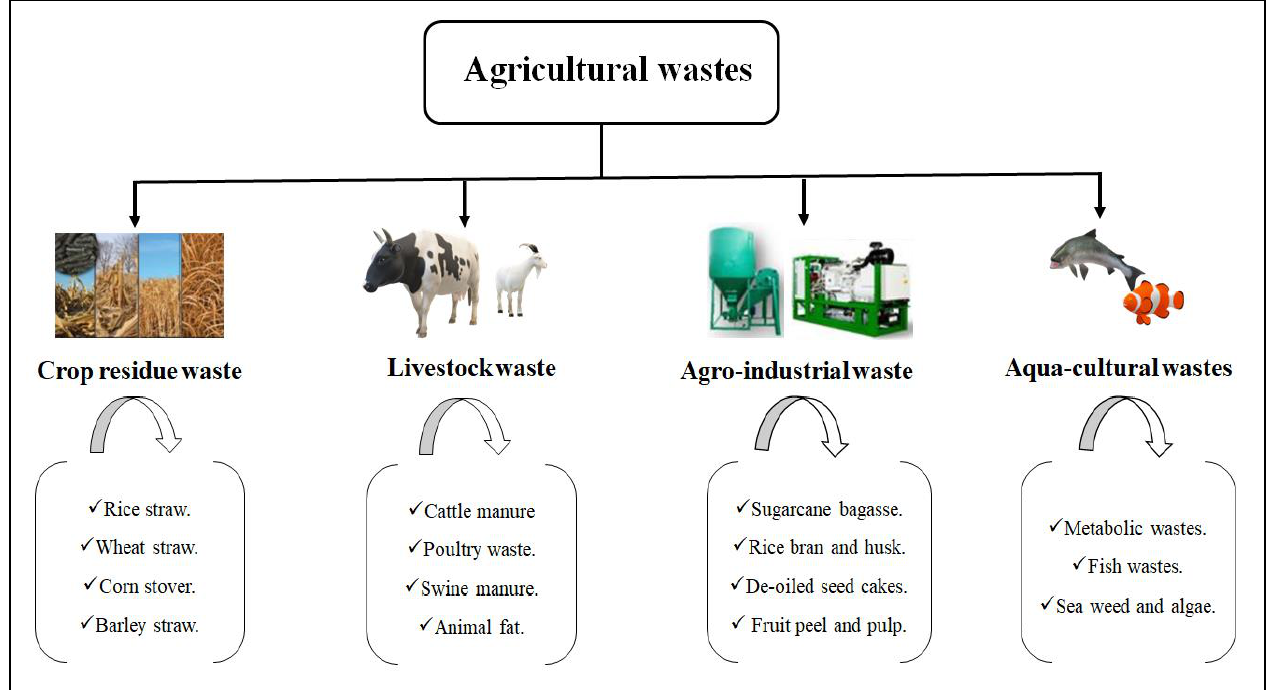
Figure 1. Illustration of different sources of agricultural waste categories.